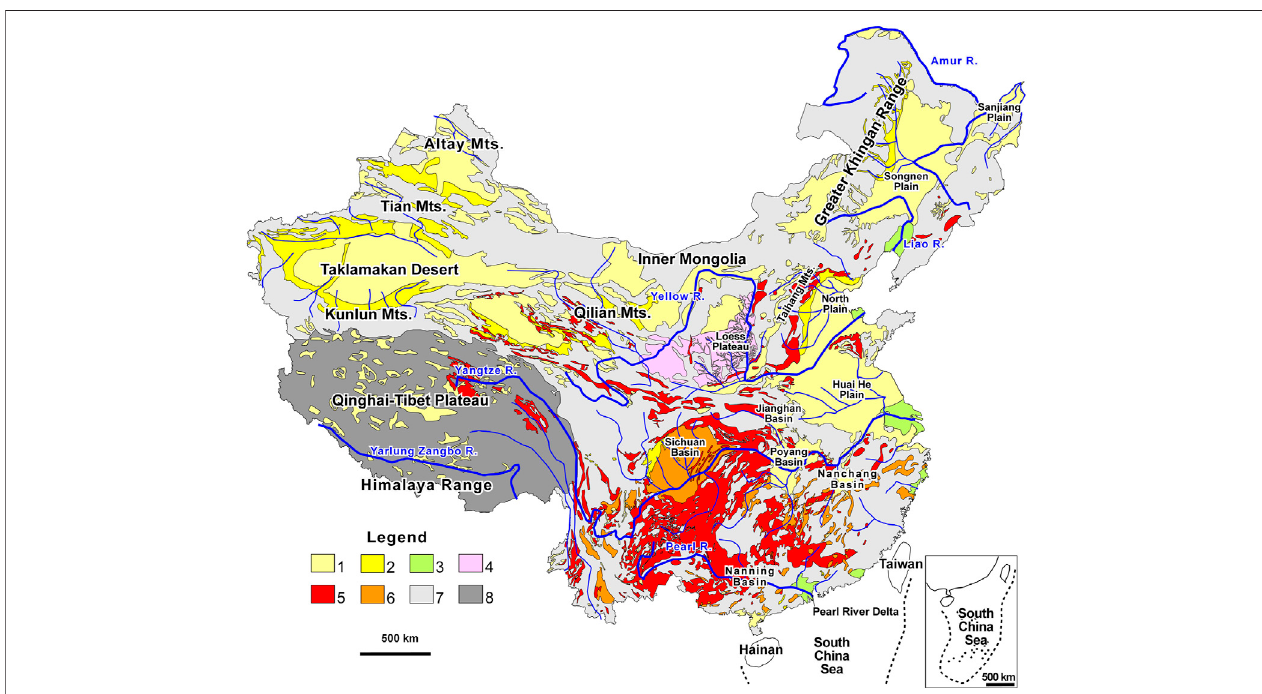
FIGURE 4 | Hydrogeological map of China. Key to the Legend: 1) Alluvial sequence; 2) Piedmont bands; 3) Delta 4) Loess; 5) Fissured Bedrock; 6) Karsti fi ed carbonate sequence; 7) Impervious bedrock; 8) Permafrost. Redrawn and simpli fi ed from CGS (1979).